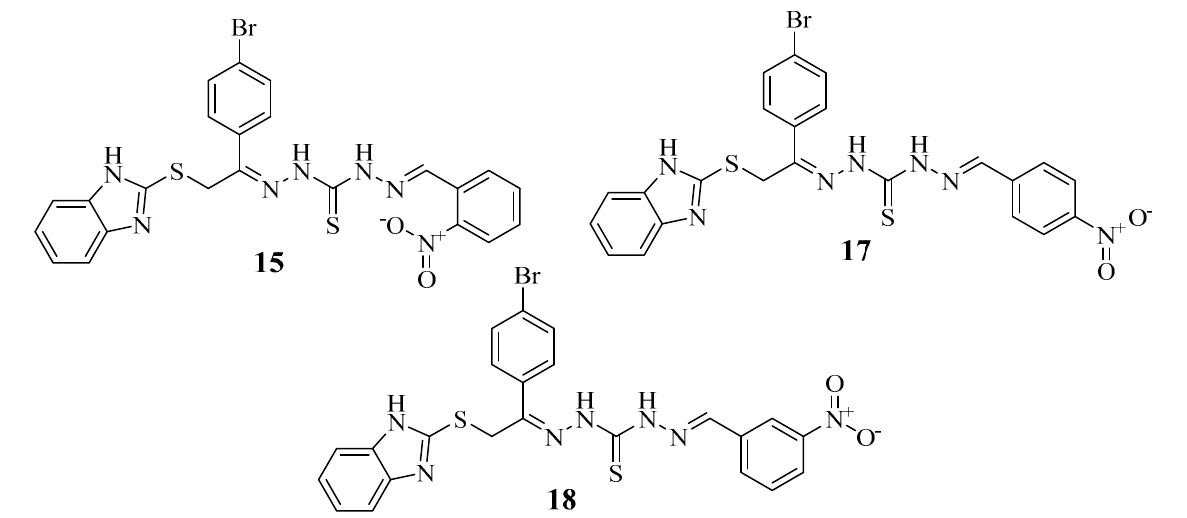
Figure 7. Structure–activity relationship of derivatives 15 , 17 and 18 .